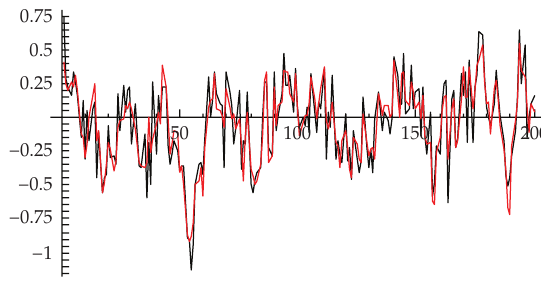
Figure 1: x 1 (cid:5) k (cid:6) and (cid:11) x 1 (cid:5) k/k (cid:6) versus k